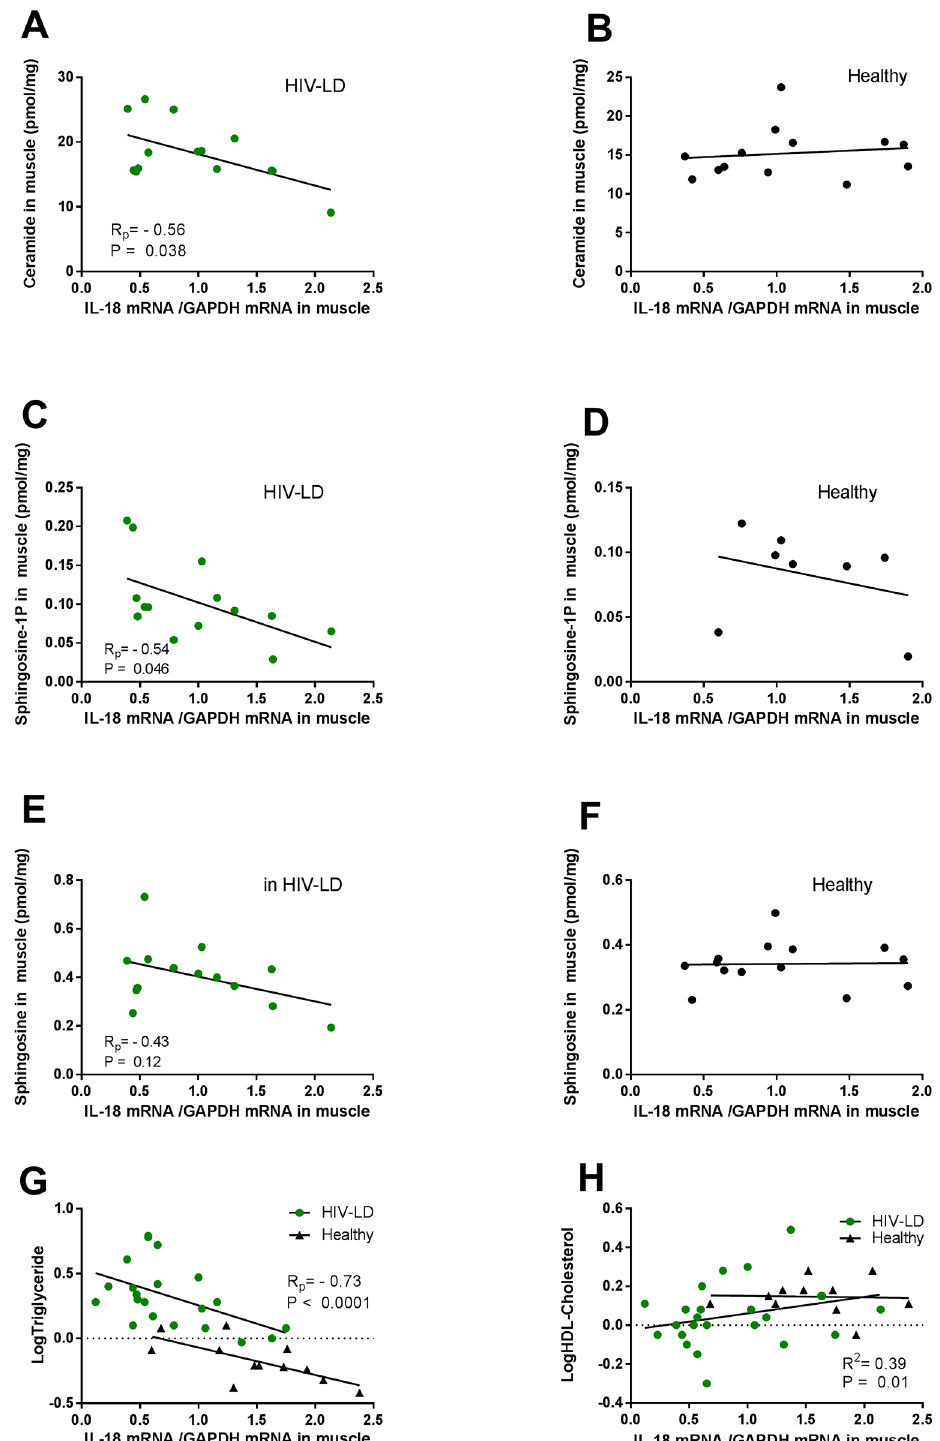
Fig 3. The correlation relationship between muscle IL-18 mRNA and muscle sphingolipid content, circulating triglycerides and HDL-cholesterol in patients with HIV-lipodystrophy (to the right) and in healthy controls (to the left). IL-18 mRNA in muscle is negatively correlated to ceramide (A) and sphingosine-1P (C) content in muscle in patients with HIV-Lipodystrophy, but not in healthy controls (B, D, F). Il-18 mRNA in muscle is negatively correlated to triglycerides in patients with HIV-Lipodystrophy and in healthy controls (G), and positively correlated to